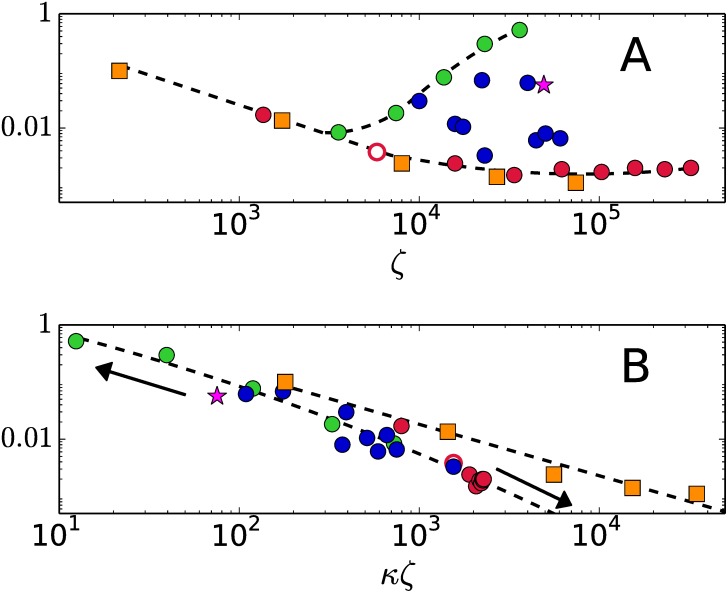
Fraction of CPU time consumed by Algorithm 5 to traverse the set of extreme points.A.- As a function of the input size ζ. B.- As a function of the combined output-input size κζ.